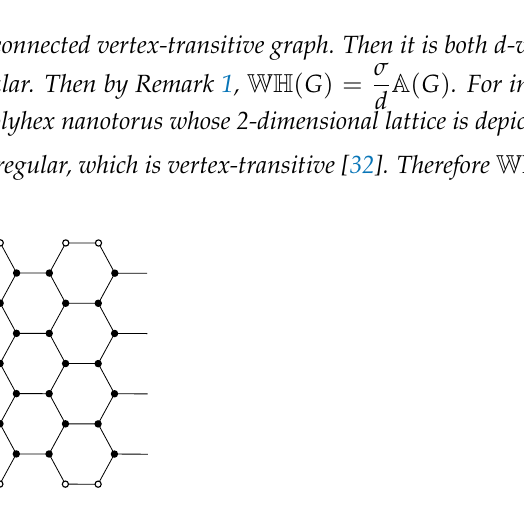
Figure 2. A graph which is both transmission regular and vertex-degree regular, but not vertex-